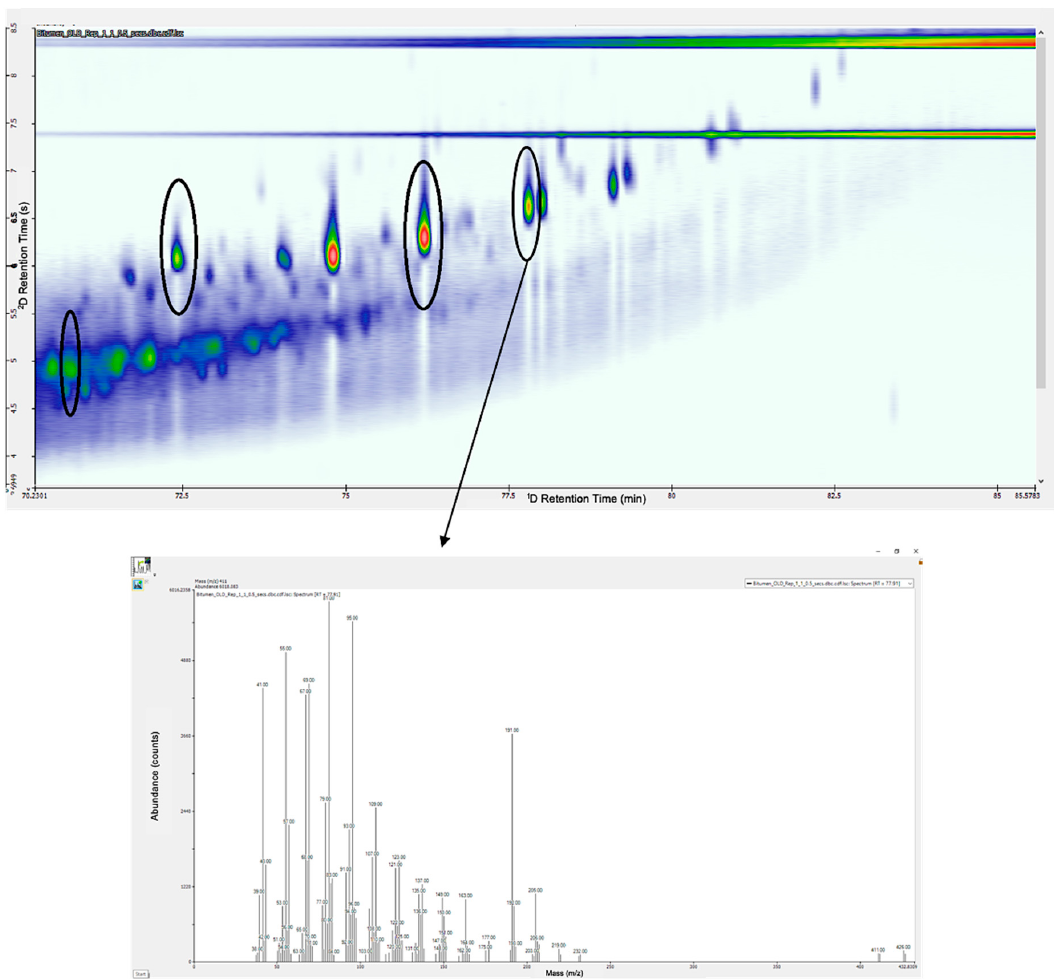
Figure 6. Mass spectrum of a C31 late eluting terpane found in the cyclohexane bitumen oil sands